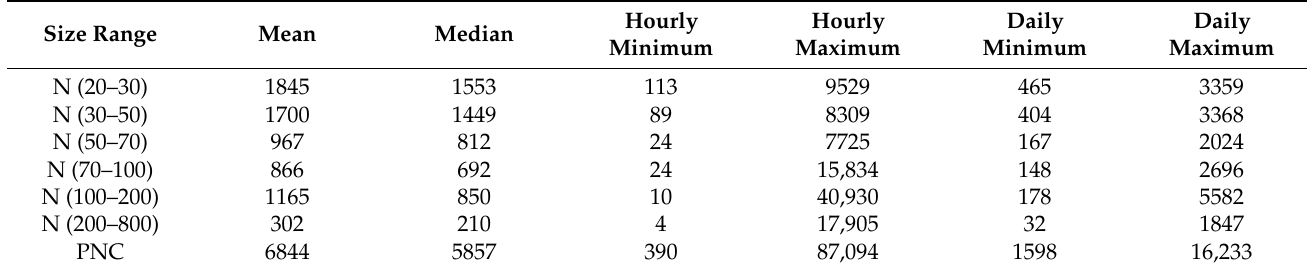
Table A1. Descriptive statistics of ultrafine particle number concentrations (particle/cm 3 ) over the measurement period on background site (Strasbourg-Danube).